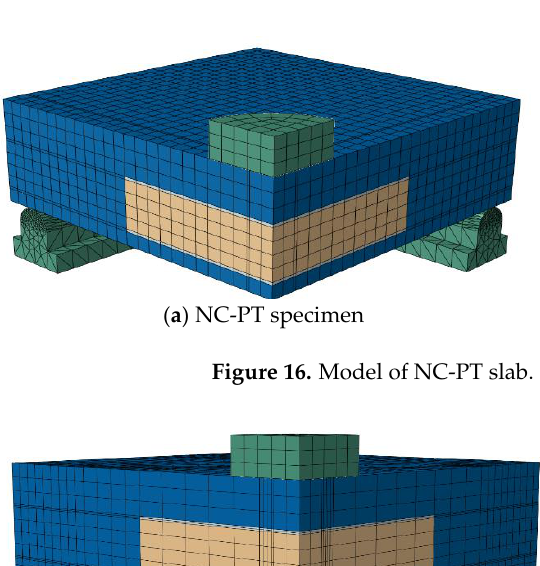
Figure 15. Model of NC-OA slab.